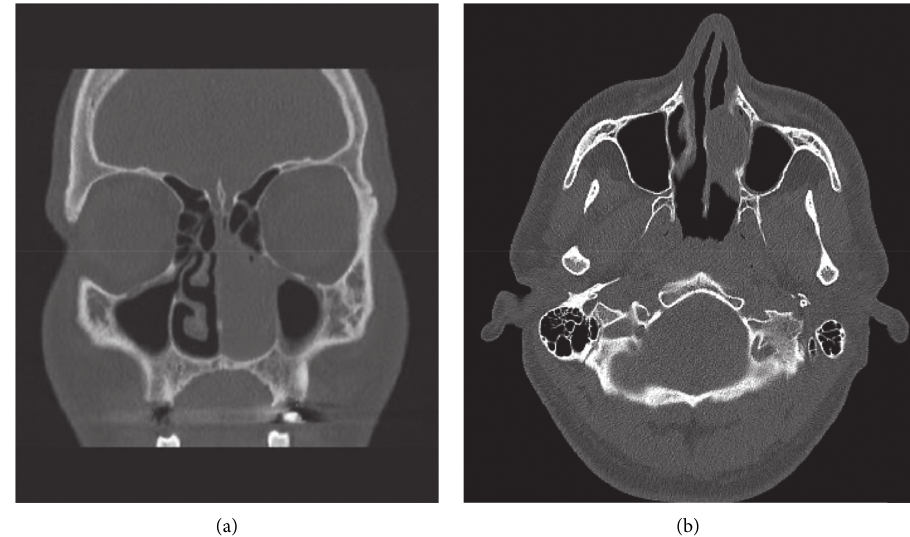
Figure 2: CT scan of the paranasal sinuses with contrast. The coronal and axial section shows a left anterior nasal